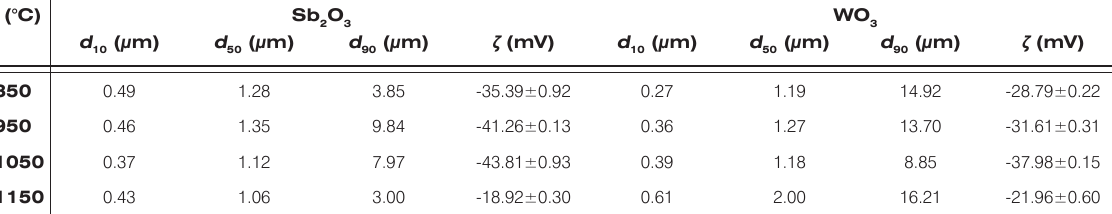
Cr M O (x = 0.4 0.2 0.4 2